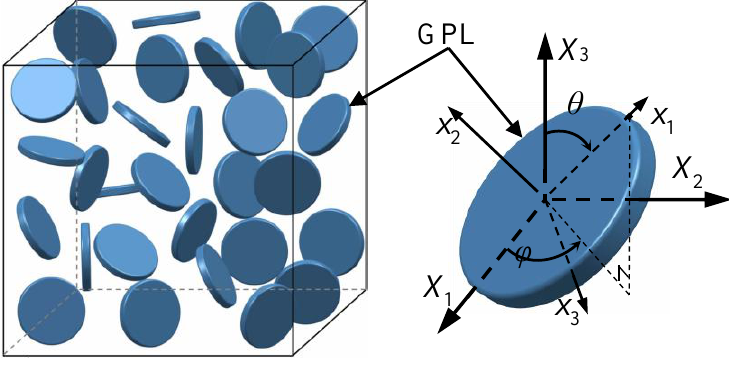
Figure 1. Sketch of a microscale RVE containing GPLs.